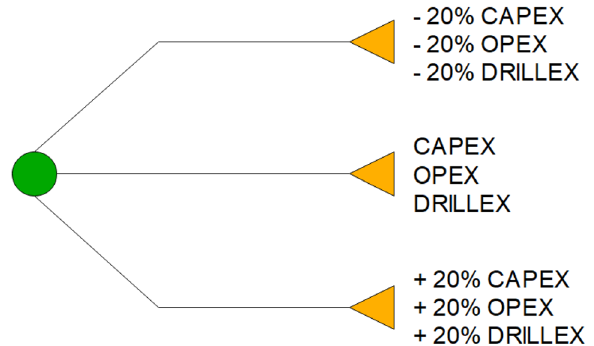
Fig. 11 Comparison of NPV’s cumulative density function for all recovery scenarios